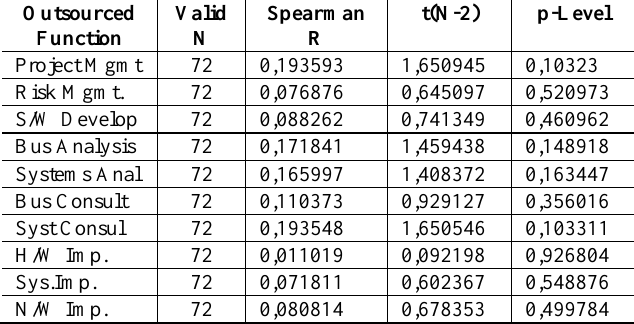
Table 6: Spearman correlation for size vs outsourced functions